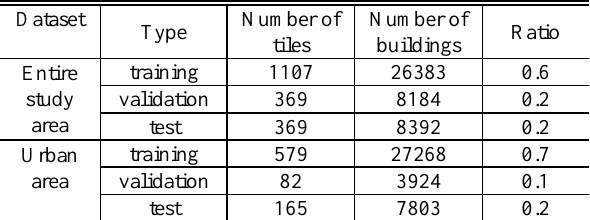
Table 1. Information of training, validation, and test set for the two study areas. The size of each tile is 1024×1024